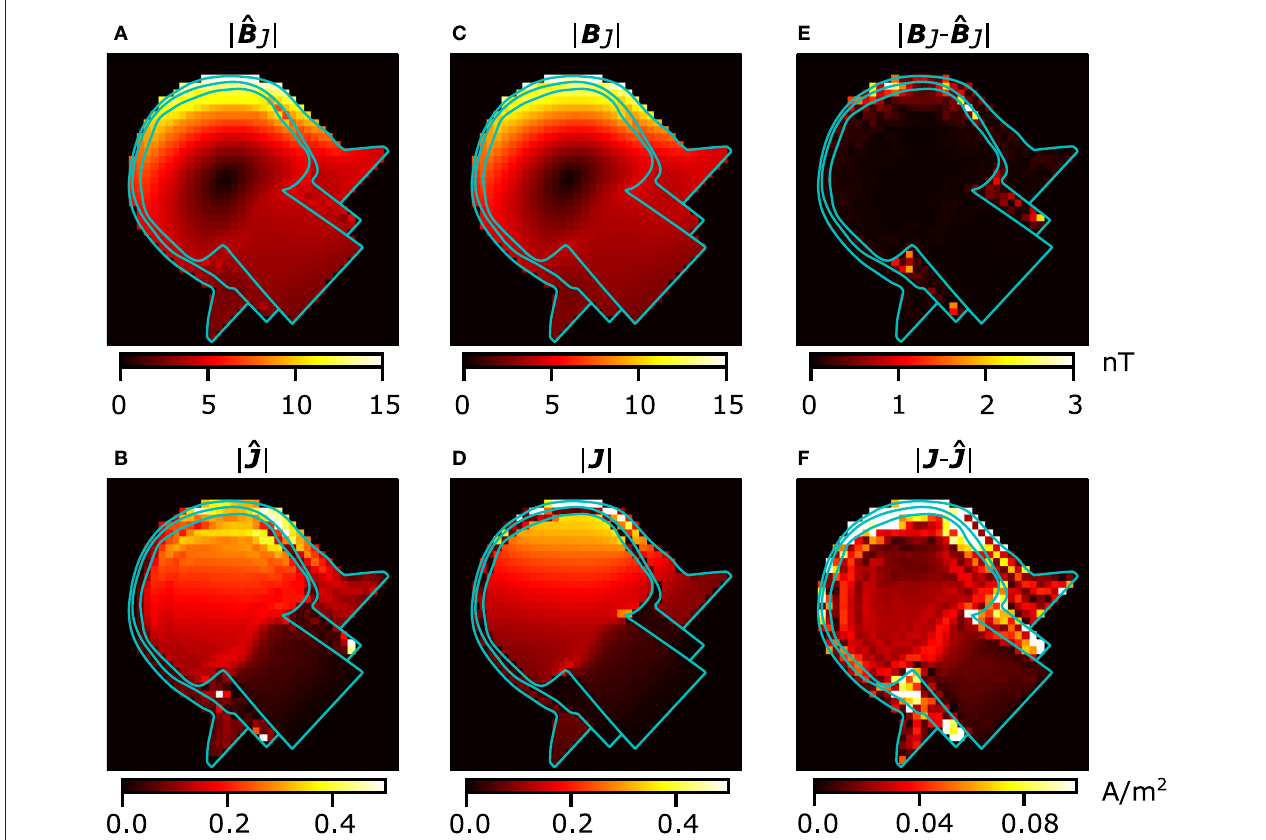
FIGURE 8 | Comparison of the simulated noiseless CDI reconstructions and the FEM solutions. The corresponding coordinates are given in Figure 6B . (A) shows the reconstructed magnetic field and (B) the reconstructed current density. (C,D) show the respective FEM solutions, and (E,F) display the absolute differences between reconstructions and the FEM solutions. The FEM fields are linearly interpolated from the FEM nodal values to the (5 masked to zero outside the head model. Note that the color axes of the right-most figures differ from the others by a factor of